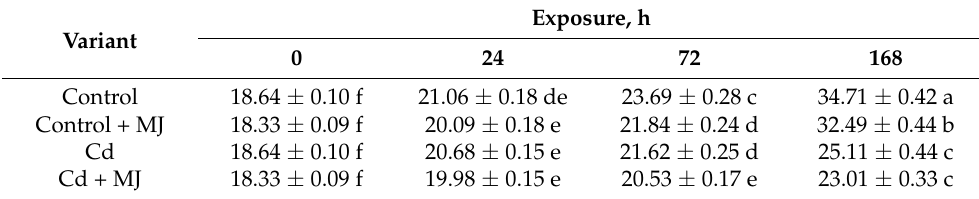
Table 2. Effect of MJ on height (cm) of wheat seedlings.